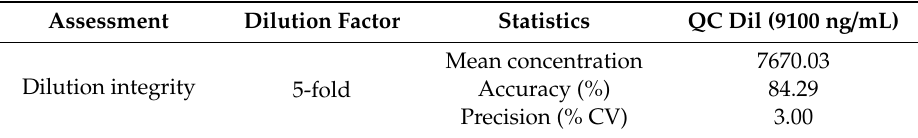
Table 3. The dilution integrity assessments of SCH 58261 in rat plasma ( n = 3).